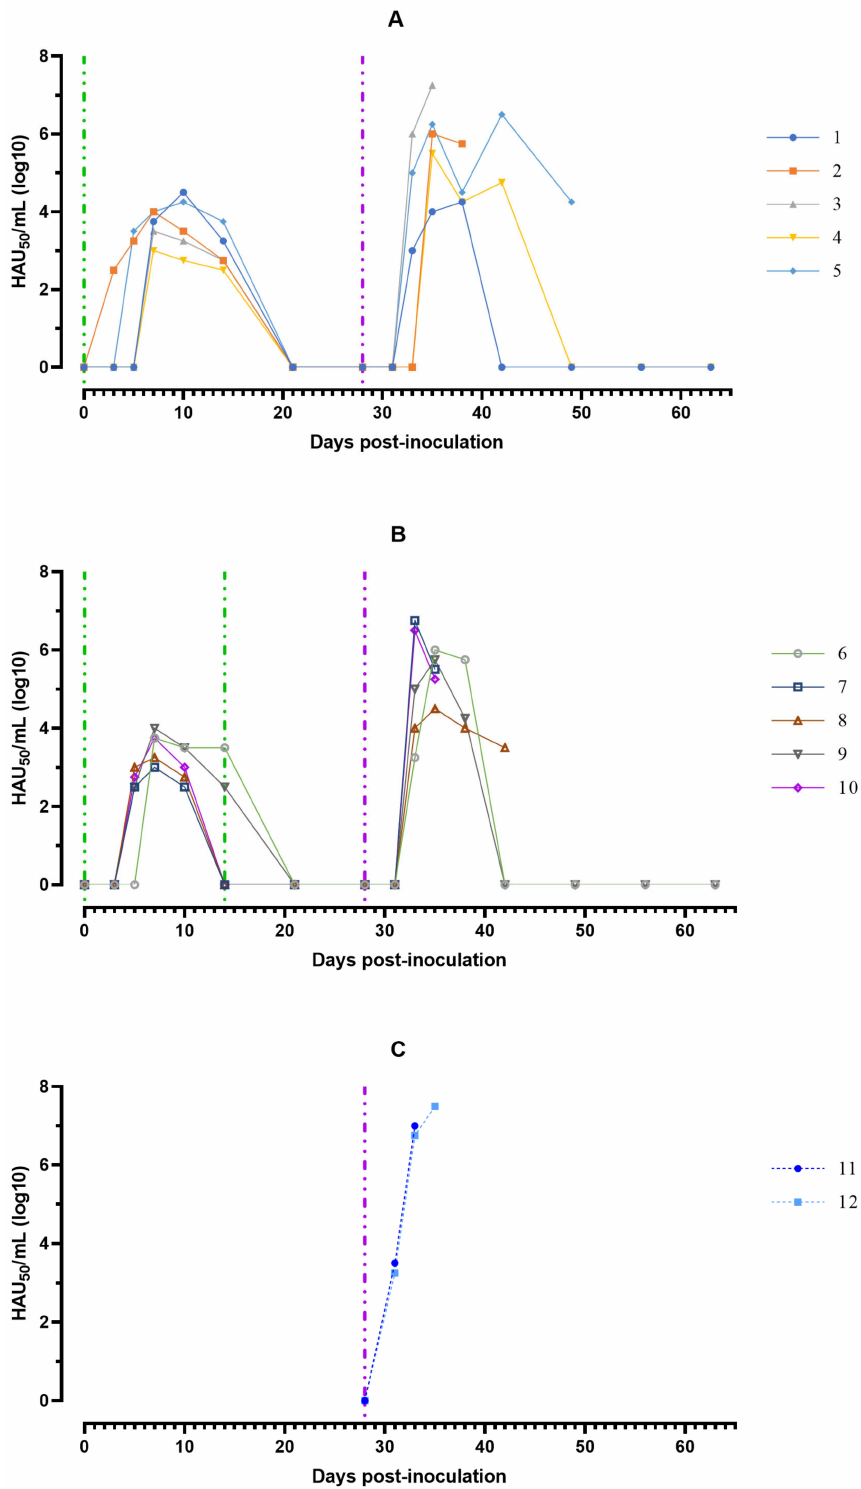
Figure 3. Virus titres in blood samples obtained from pigs: ( A ) group #1 after inoculation with the ASFV-Katanga-350 and challenge on the 28th day with the ASFV-Stavropol 01/08; ( B ) group #2 after two inoculations with the ASFV-Katanga-350 and challenge on the 28th day with the ASFV- Stavropol 01/08; ( C ) group #3 after challenge with the ASFV-Stavropol 01/08. Each bar represents an individual animal’s values. Vertical dashed lines: green—days of inoculation of ASFV-Katanga-350, purple—challenge by the ASFV–Stavropol